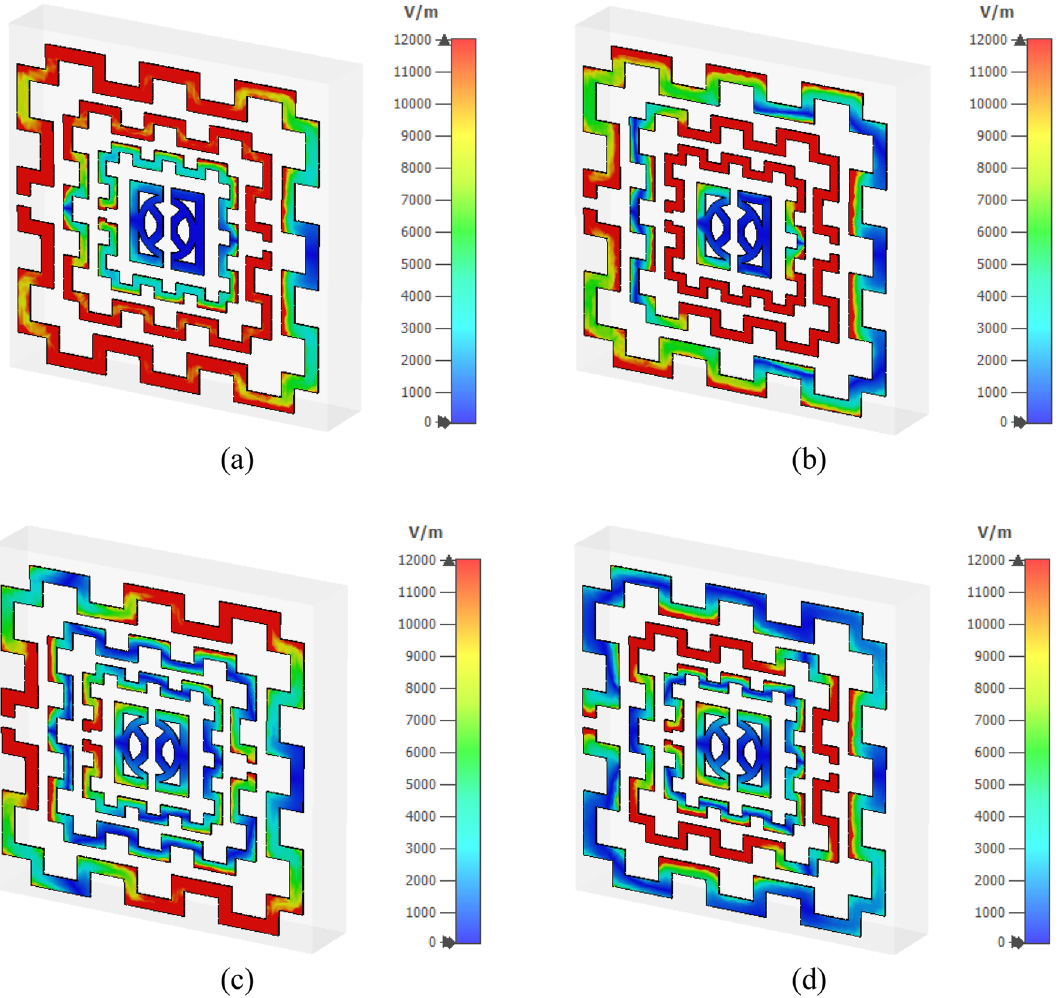
Figure 13. Electrical field distribution at four resonance frequencies ( a ) 2.48 GHz ( b ) 4.28 GHz ( c ) 9.36 GHz ( d ) 13.70 GHz. (CST STUDIO SUITE 2019, https:// www. 3ds. com/ produ cts- servi ces/ simul ia/ produ cts/ cst- studio- suite) 28